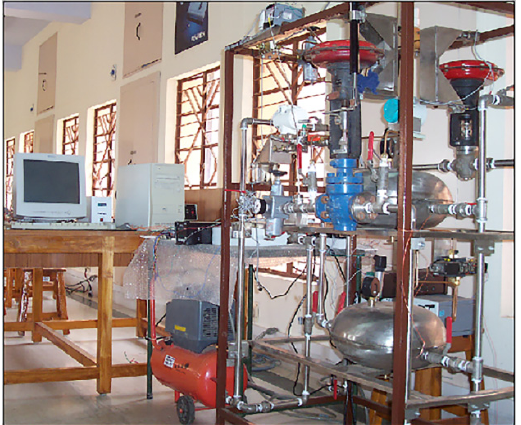
Figure 1. Pneumatic pressure control, schematic diagram.